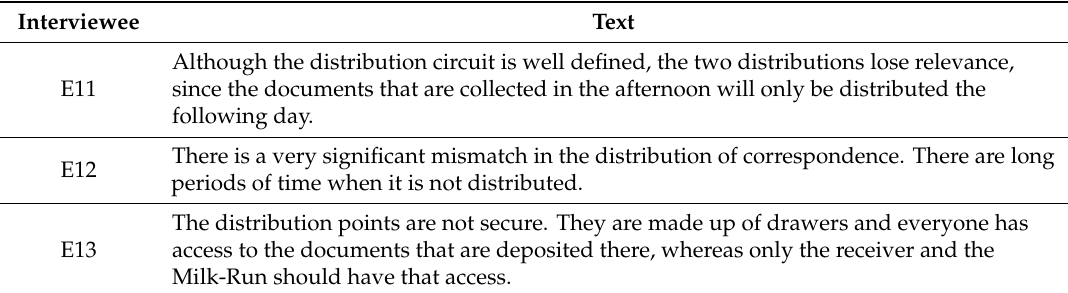
Table 3. Content analysis—Impact of the postal sector on the Air